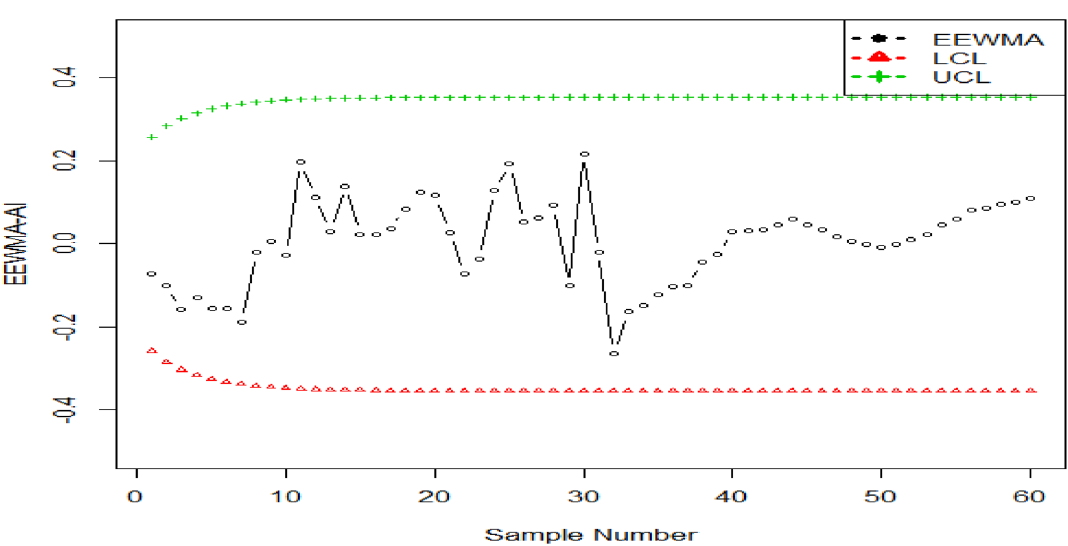
Figure 2. The EEWMA control chart for simulated